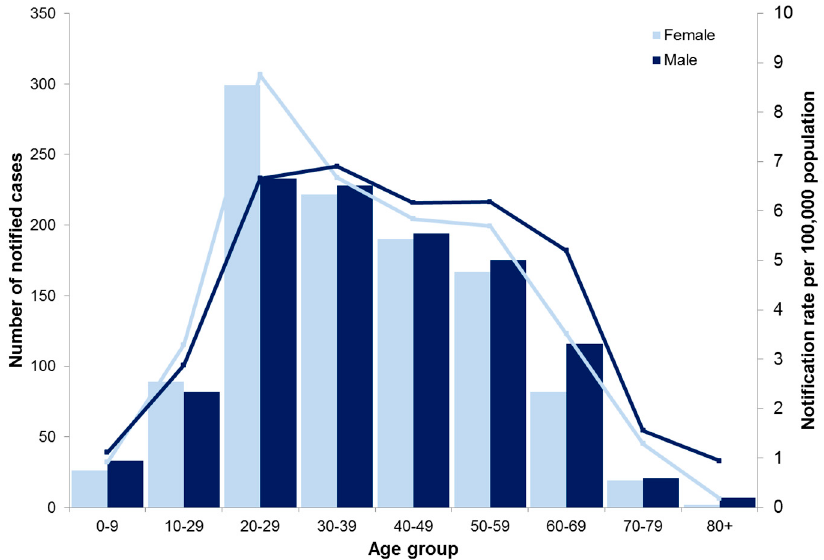
Figure 2. Number and notification rate of dengue cases, by age and sex, 2010–2016, Victoria.